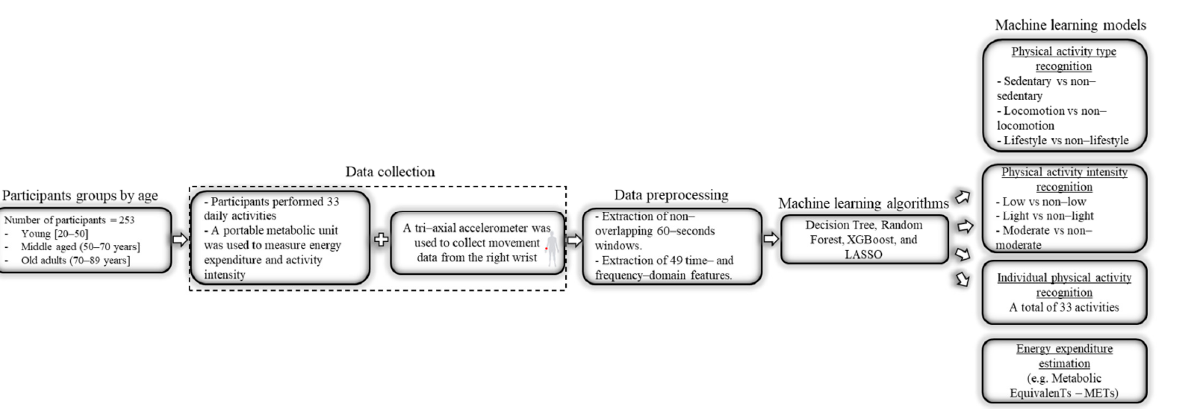
Figure 1. A block diagram showing the steps followed to collect and process the data.